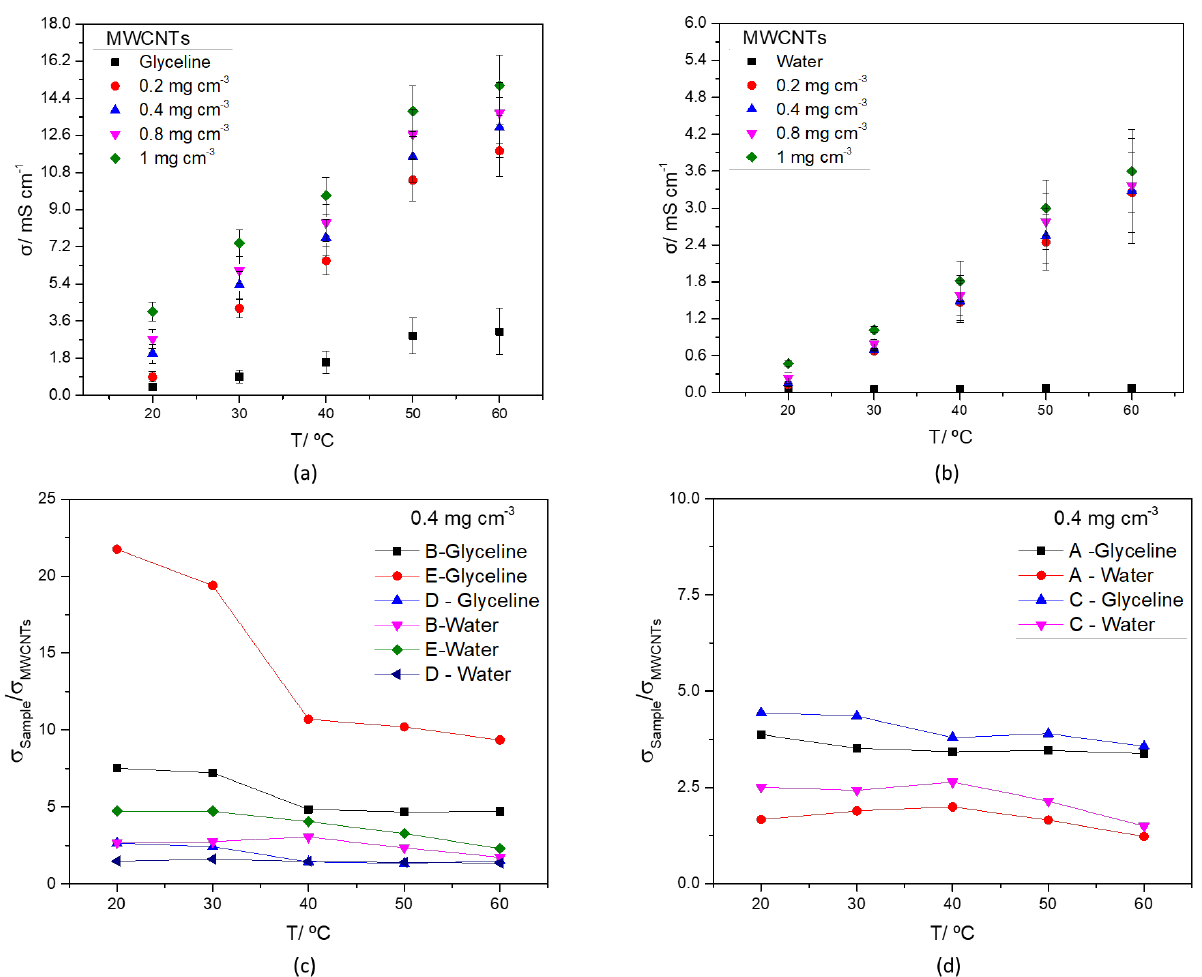
Figure 7. Ionic conductivity of MWCNTs mixtures (0.2–1.0 mg cm −3 ) in glyceline ( a ), water ( b ) as a function of temperature, and ionic conductivity ratio of AgMWCNTs (0.4 mg cm − 3 ) Samples B, function of temperature, and ionic conductivity ratio of AgMWCNTs (0.4 mg cm −3 ) Samples B, D and E ( c ) and A and C ( d ) as a function of temperature, in glyceline and water.